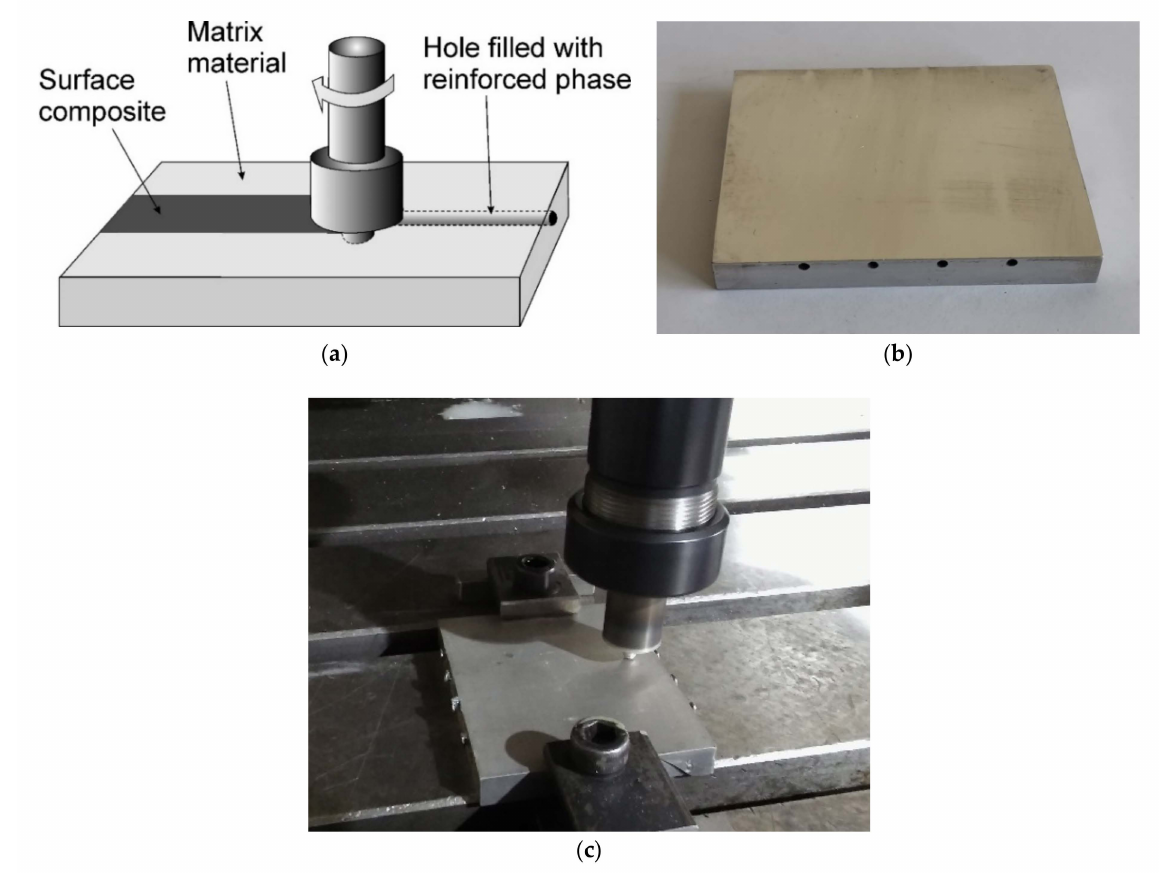
Figure 7. Diagram of holes drilled under surface method ( a ) (authors’ own drawing), sample for processing with hole drilled under surface method ( b ), FSP stand ( c